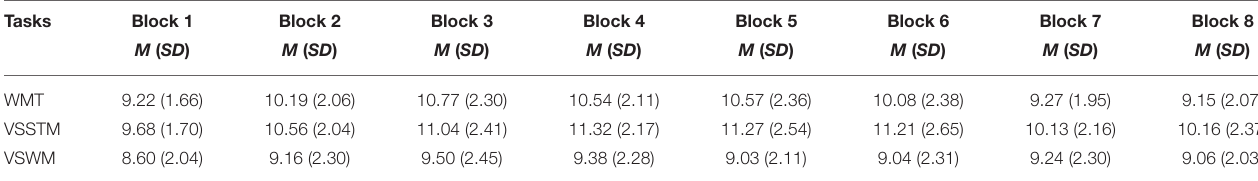
TABLE 3 | Performance for working memory tasks for the typically developing and children with ADHD over 8 blocks (each with 5 sessions) for all working memory training tasks (WMT) combined, and for visuospatial short-term training tasks (VSSTM) and visuospatial working memory training tasks (VSWM) separately ( N = 90). Tasks